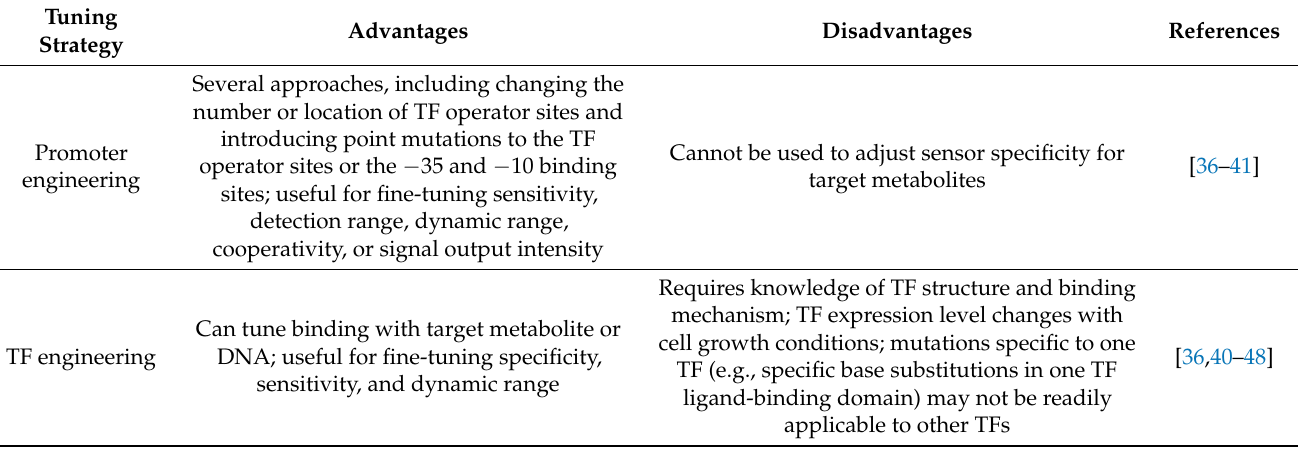
Table 1. Advantages and disadvantages of tuning strategies for